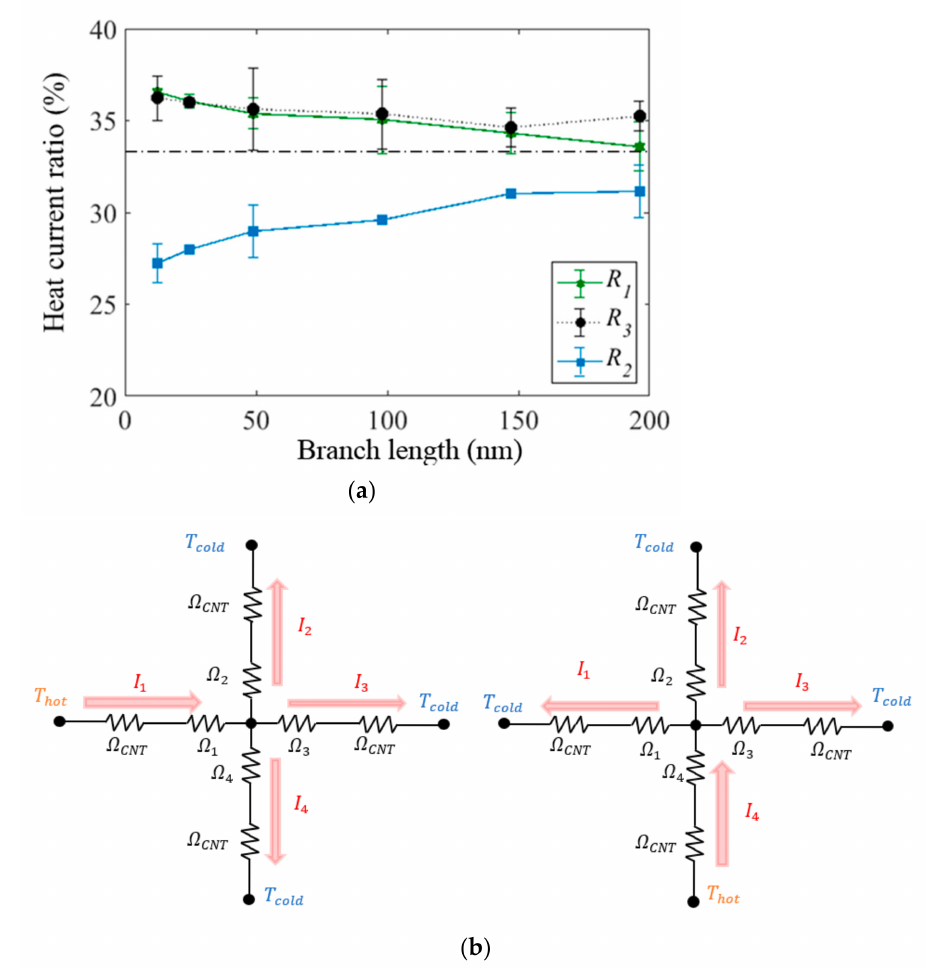
Figure 6. ( a ) Length dependence of the heat current ratio for branched CNTs with cross-junction 1. A hot region was created at the bottom branch (branch 4), and cold regions were created at the other branches. ( b ) Conventional thermal circuit when assuming different thermal resistances at the junctions.